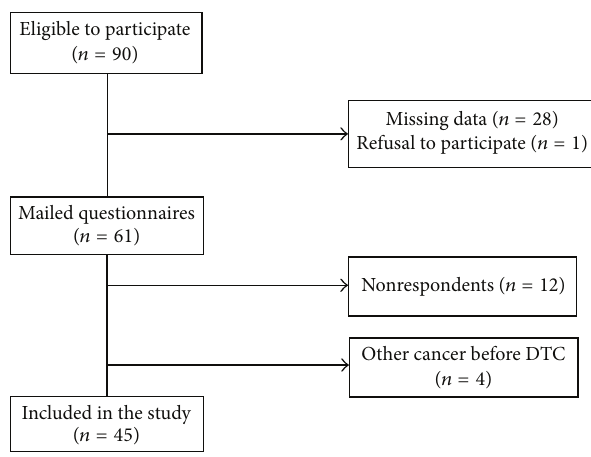
Figure 1: Flow chart of study participants.